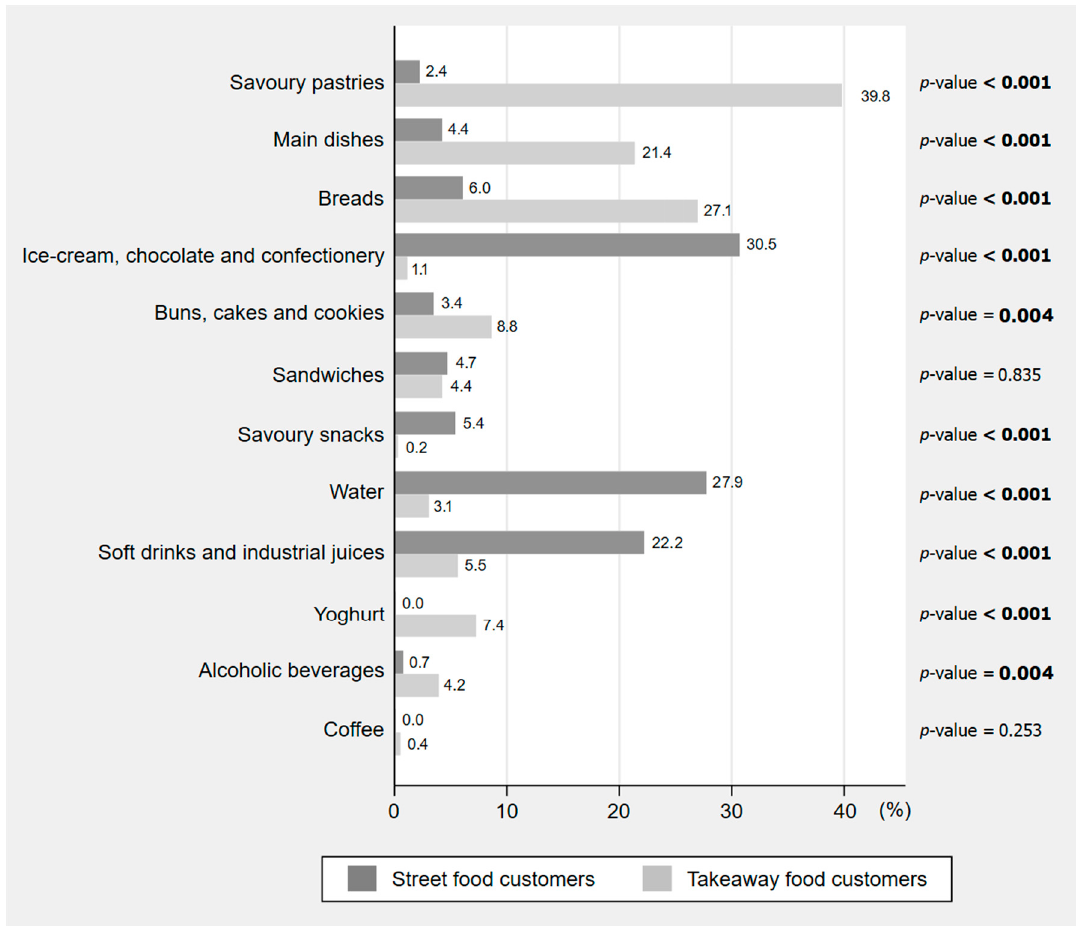
Figure 1. Ready-to-eat foods and beverages purchased by the customers observed in street food and takeaway food vending sites in Sarajevo and Banja Luka, Bosnia and Herzegovina ( n = 755). The proportions presented are relative to the total number of customers from each type of vending site (street food: n = 298; takeaway food: n = 457). The sum of the percentages may exceed 100% because the same customer could buy more than one food or beverage. Values in bold represent statistically significant differences according to Pearson’s Chi-squared test with a significance level of 0.05.